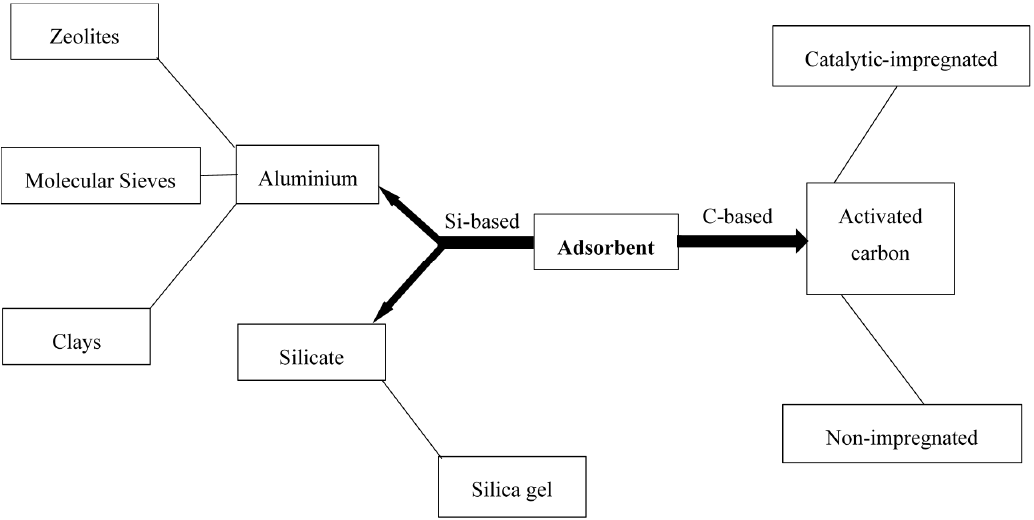
Figure 3. Silicon and carbon based adsorbents for siloxane removal from biogas.